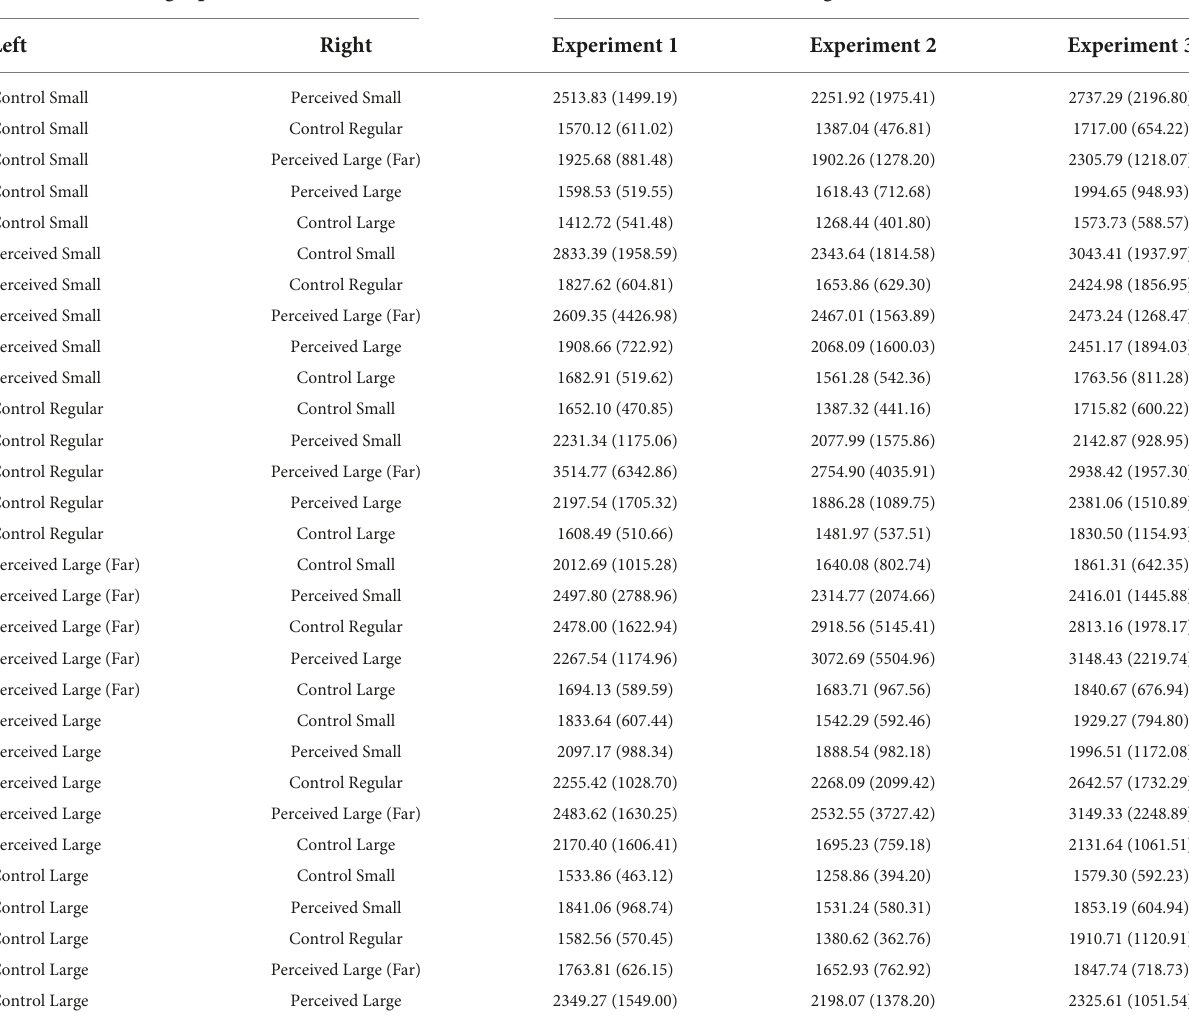
TABLE 4 Average perceptual comparison durations